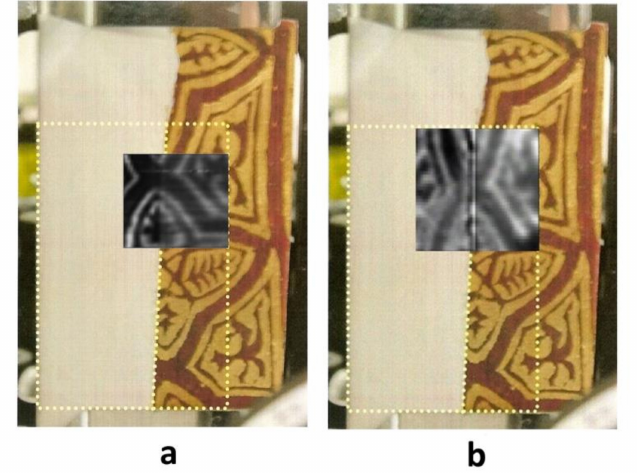
Figure 13. Comparison of the imaging performance of the FEL imaging device ( a ) and of the new imaging prototype ( b ). Size of the FEL THz image: 50 × 40 mm 2 ; size of the IMPATT THz image: 60 × 60 mm 2